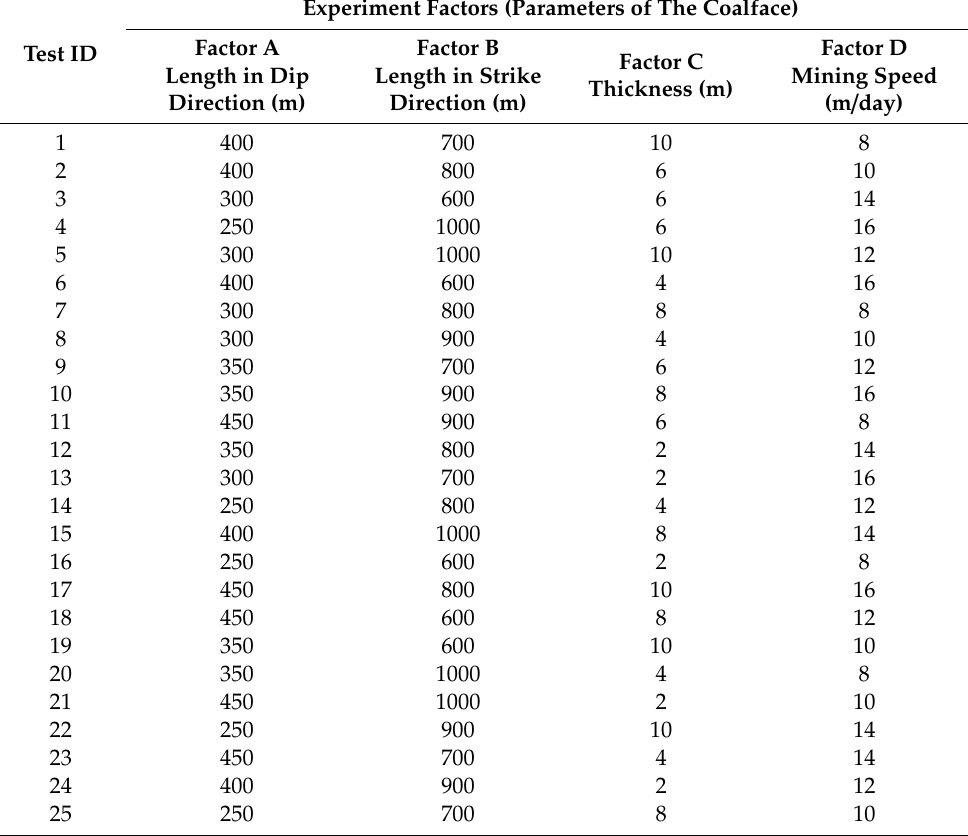
Table 2. Orthogonal experimental